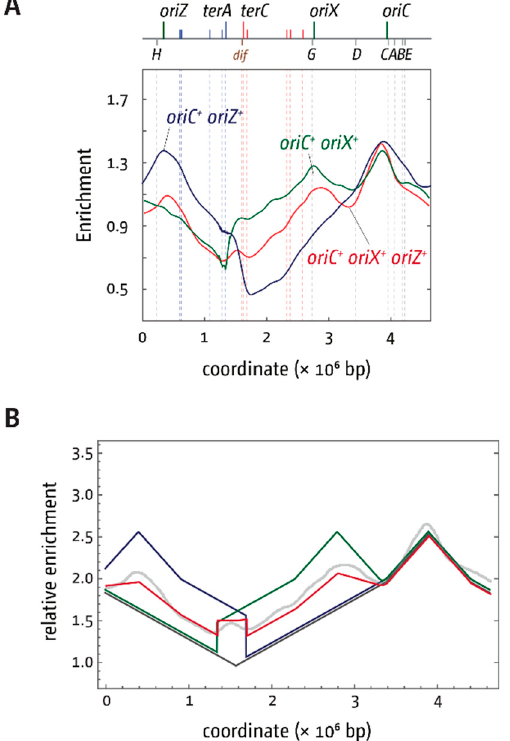
Figure 8. Comparative analysis of replication profiles of E. coli cells with two and three replication origins. ( A ) Shown is a combination of the LOESS regression profiles for oriC + oriZ + (blue), oriC + oriX + (green), and oriC + oriX + oriZ + (red) cells, as shown in Figure 6. ( B ) Mathematical model fitting for oriC + oriZ + (blue), oriC + oriX + (green), and oriC + oriX + oriZ + (red) cells. The modelling for oriC + oriX + oriZ + (red) assumes that oriC and oriX are active in 50% of cells, and oriC and oriZ are active in 40% of cells, based on the peak heights in the replication profiles. The LOESS regression curve for oriC + oriX + oriZ + cells is shown in light grey, as shown in Figure 6. See text for further details.